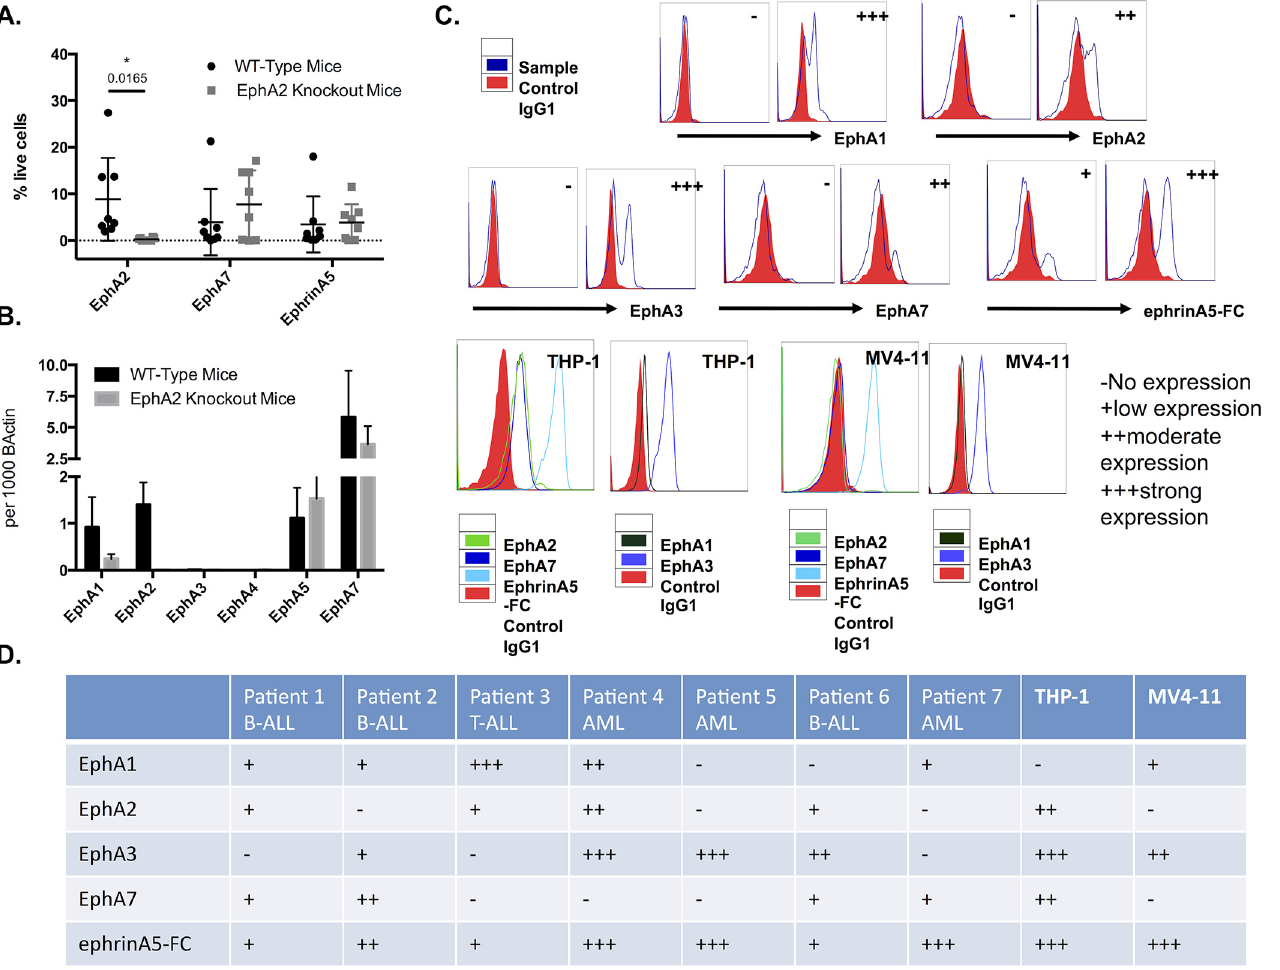
Fig 6. Expression analysis of EphA subfamily on mouse MLL-AF9 leukemic cells, on patient samples and human leukemic cell lines with MLL- rearrangement. (A) Flow cytometric analysis of EphA2, EphA7 and ephrinA5-Fc binding in EphA2 knockout and wild type bone marrow cells showed no EphA2 expression in the EphA2 knockout mice and significantly high expression of EphA2 in the wild type mice as expected (P = 0.0165). Comparable levels of EphA7 (P = 0.3099) and ephrinA5-Fc binding (P = 0.8710) expression were observed in EphA2 knockout and wild type leukemic cells. (B) RT-PCR analysis of EphA1, EphA2, EphA3, EphA4, EphA5 and EphA7 in EphA2 knockout and wild type bone marrow cells showed no EphA2 transcript in the EphA2 knockout mice compared to wild type MLL-AF9 (P = 0.0776) and comparable level of EphA1 (P = 0.3458), EphA5 (P = 0.7020) and EphA7 (P = 0.6167) transcript in EphA2 knockout and wild type mice. There was no expression of EphA3 and EphA4 observed in any of the MLL-AF9 mice (n = 4). (C) Representative overlay of flow cytometric analysis of EphA1, EphA2, EphA3, EphA7 and ephrinA5-Fc binding on patient samples and human cell lines. (D) Table summarizing the expression level of Eph receptors on patient samples (patients 1 – 7) and human leukemia cell lines (THP-1 and MV4-11). Each dot corresponds to one individual mouse. The data represent the mean ± SEM. Unpaired t test was performed for statistical